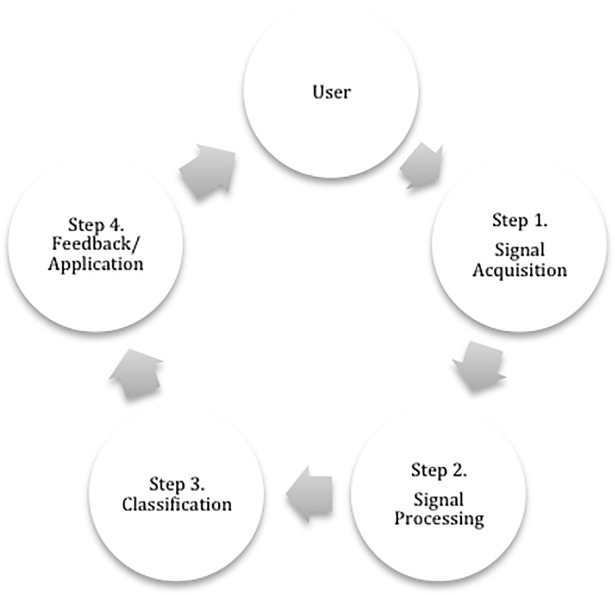
Common BCI loop.